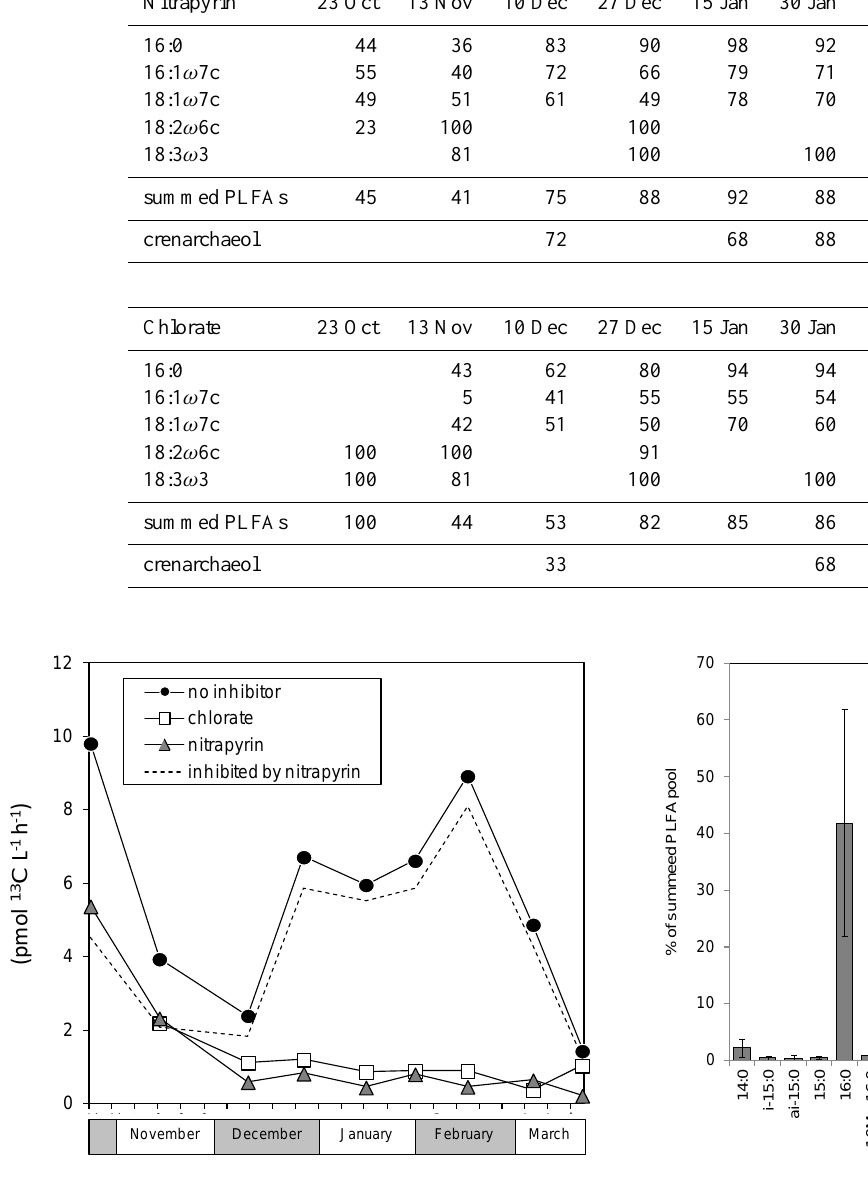
Fig. 3. Rates for 13 C-incorporation into summed PLFAs in incuba- tions with nitrapyrin, chlorate, and without inhibitors. Dashed line indicates 13 C-fixation inhibited by nitrapyrin (difference between no inhibitor and nitrapyrin). Figure 3